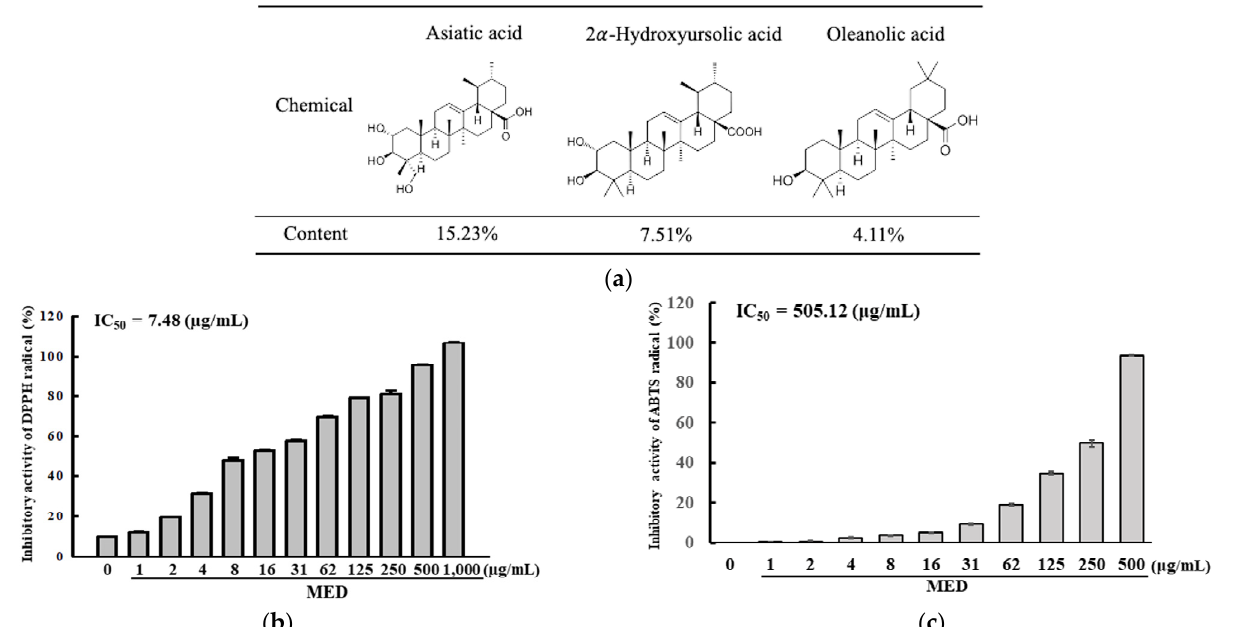
Figure 1. Main components and free radical scavenging activity of MED. ( a ) Concentration of asiatic acid, 2 α -hydroxyursolic acid and oleanolic acid in MED. ( b ) DPPH radical scavenging activity of MED. This activity was measured in the concentration ranges from 1 to 1000 µ g/mL of MED. Scavenging activity analysis for DPPH radicals was conducted with three MED samples. ( c ) ABTS radical scavenging activity of MED. This activity was measured in the concentration ranges from 1 to 500 µ g/mL of MED. Scavenging activity analysis for ABTS radicals was conducted with three MED samples. All values in the results are represented as the means ± standard deviation